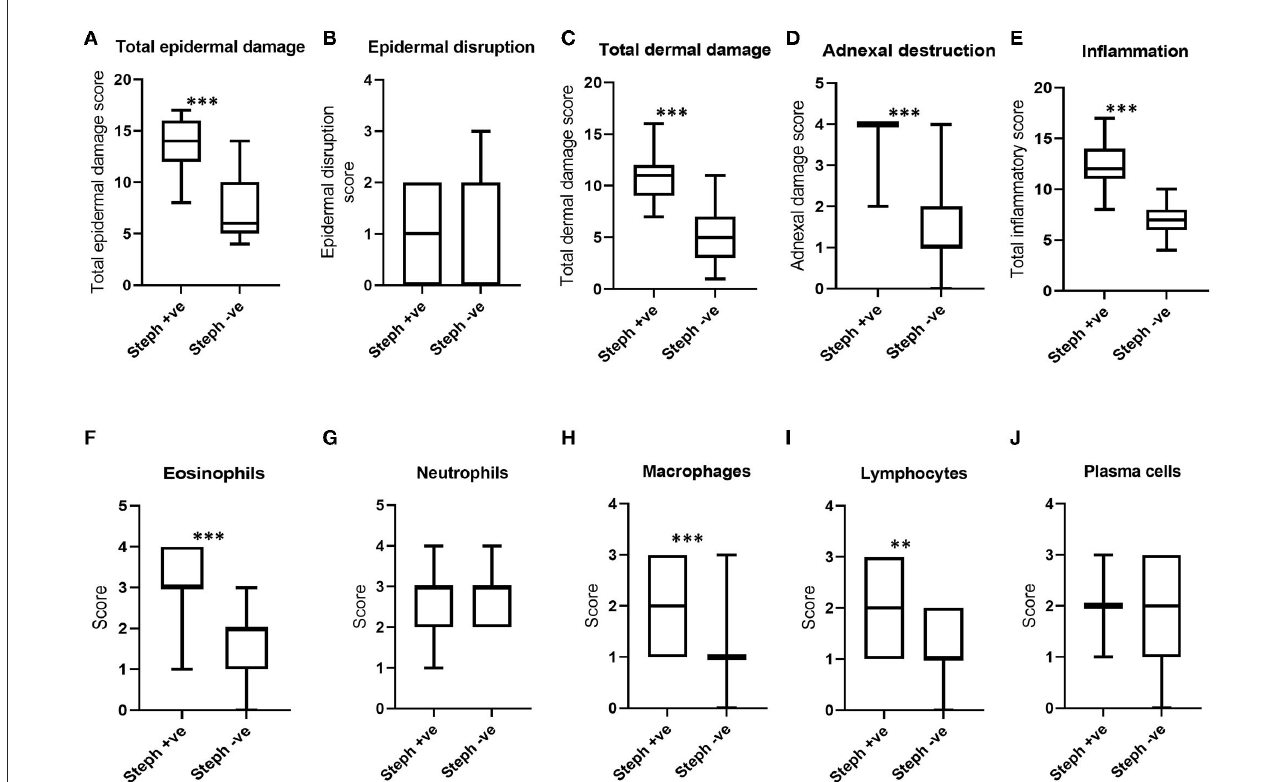
FIGURE5 Boxplots (A–D) show the distribution of scores for total epidermal damage, epidermal disruption, total dermal damage and adnexal destruction scores for Stephanofilaria positive (Steph + ve) and negative (Steph -ve) lesions. The boxplots (E–J) show the total inflammation and individual inflammatory cell scores of these two groups ( ** P < 0.01, *** P <